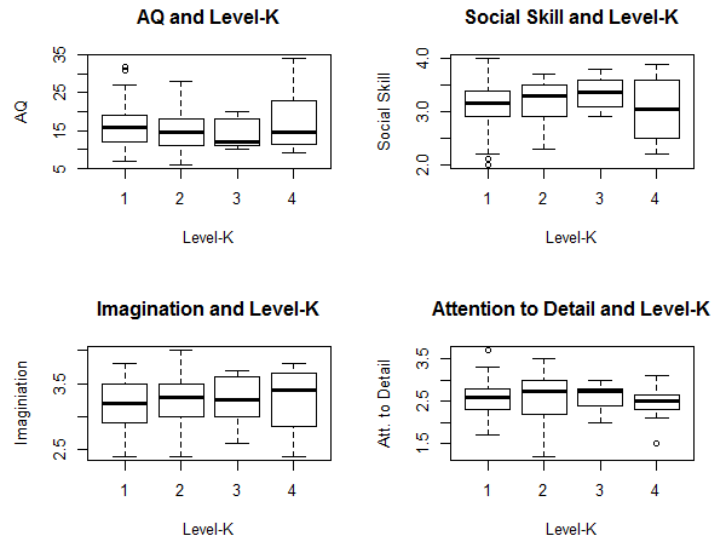
Figure 4. Scores as a function of level-K.